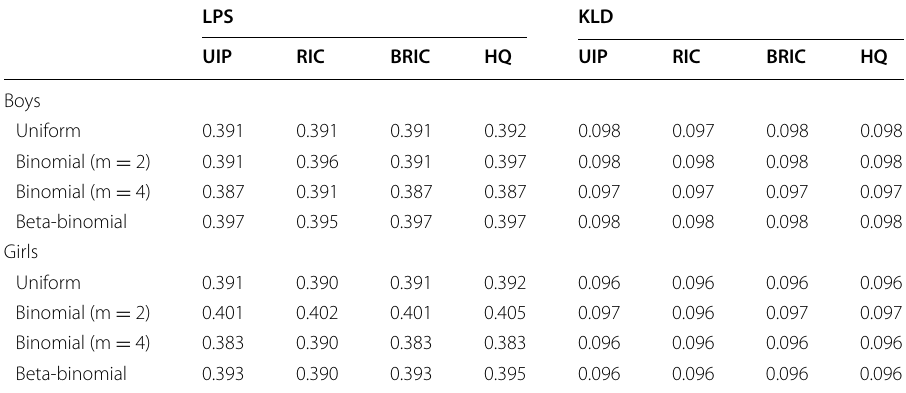
Table 4 Summary of log-predictive scores and Kullback–Leibler divergences for boys and girls in the fixed priors